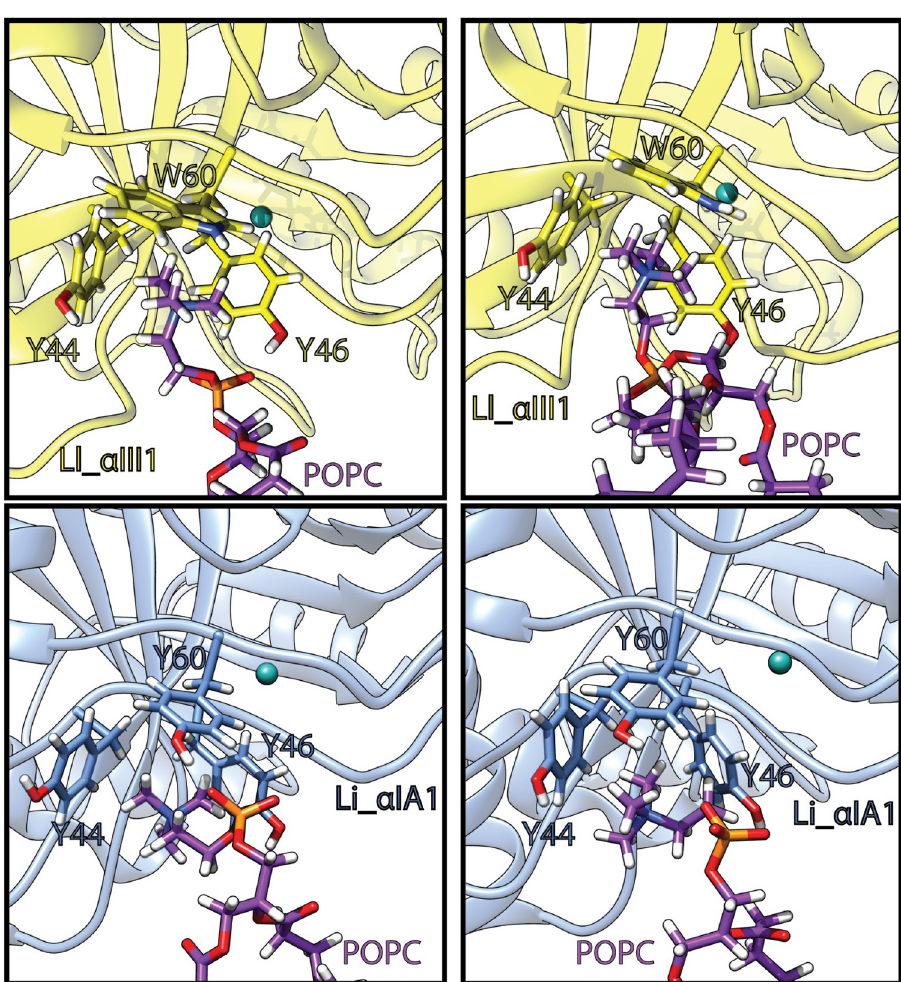
Fig 4. Phosphatidylcholine headgroups trapped in the aromatic cage of Li_ α IA1 (blue) and Ll_ α III1 (yellow). Lipids carbon atoms are in purple, the magnesium ion is represented as a cyan ball. The snapshots are extracted from the last 150ns of the simulation